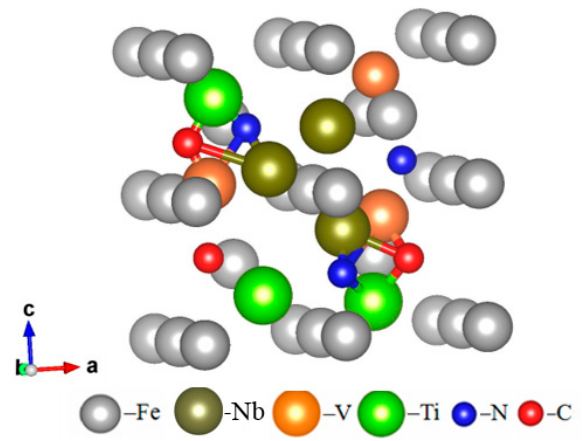
Figure 9. Atomic model of the Fe-Nb-V-Ti-N-C system coupling precipitation. The multiple microelements coupling precipitation behavior was thermodynamically analyzed in N2 steel, and its complete solution temperature T AN was 1628.74 ◦ C, which is 116.69 ◦ C higher than the corresponding liquidus temperature of 1512.05 ◦ C [16,35]. As is known for micro-alloy steels, if the complete dissolution temperature is above the liquidus